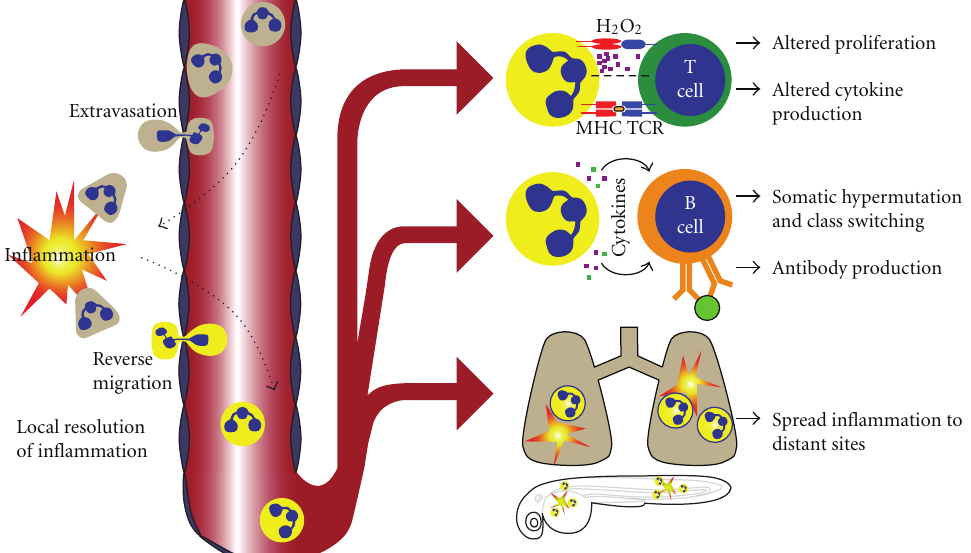
Figure 3: Potential functions of reverse migrated neutrophils. On the left side of the illustration, neutrophils (tan) are responding to an extravascular inflammatory stimulus. After responding to the stimulus, neutrophils perform reverse migration (yellow) and enter the vasculature. This process has been suggested as a mechanism to resolve inflammation at the local level. We are proposing the following as potential functions of reverse migrated neutrophils. Neutrophils may modulate T-cell proliferation and cytokine production in an antigen- independent or-dependent manner. Integrin-mediated neutrophil-T cell contact, hydrogen peroxide, and T cell receptor (TCR) signaling have demonstrated importance in neutrophil-mediated regulation of T cell function. Neutrophils may promote antibody diversification, class switching, and production by splenic B cells through the secretion of cytokines. Reverse migrated neutrophils may travel to distant tissues and induce additional inflammation. Reverse-migrated neutrophils were implicated in inducing pulmonary inflammation in